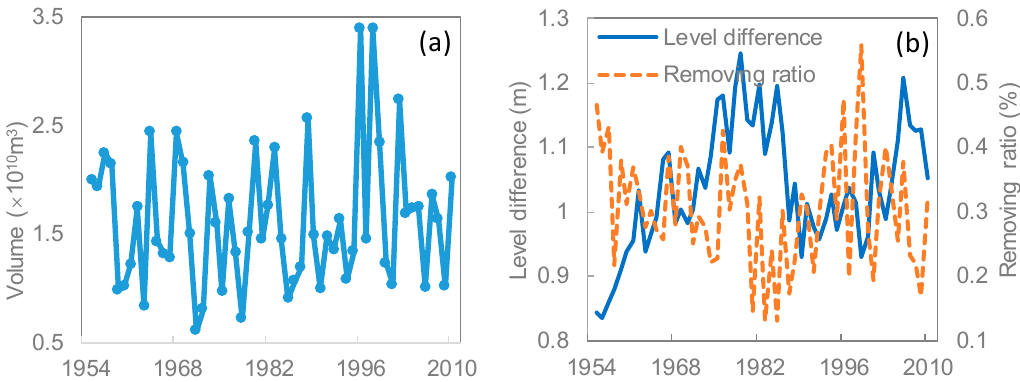
Figure 4. Dynamics of the maximum flood regulation volume ( a ), and relationship between the flood peak reduction ratio and the water level difference downstream of the lake ( b ).